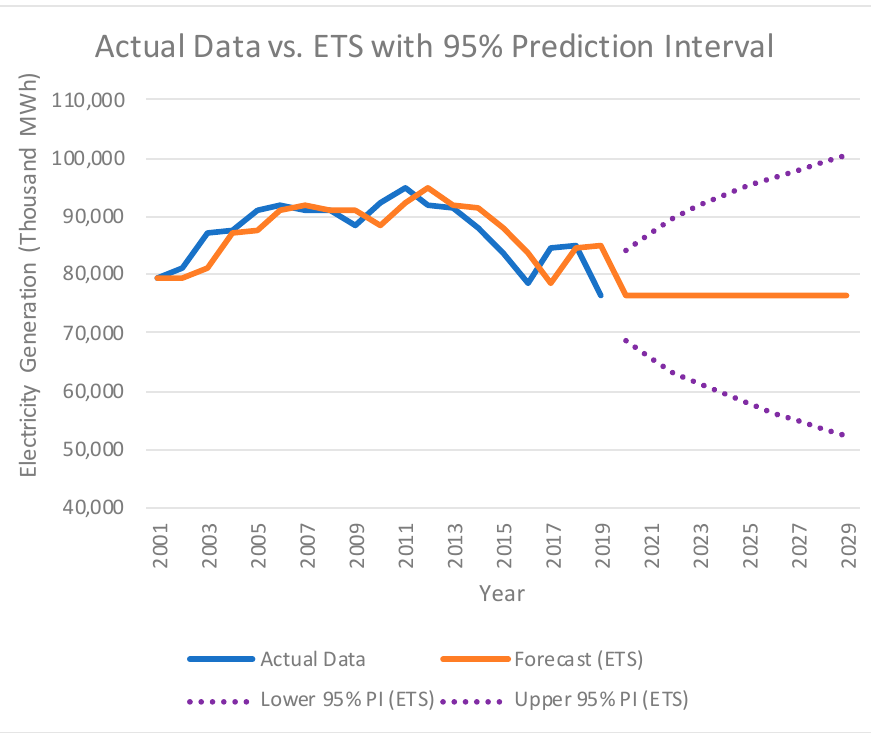
Figure 3. Forecasting Model Comparison with Predictions.